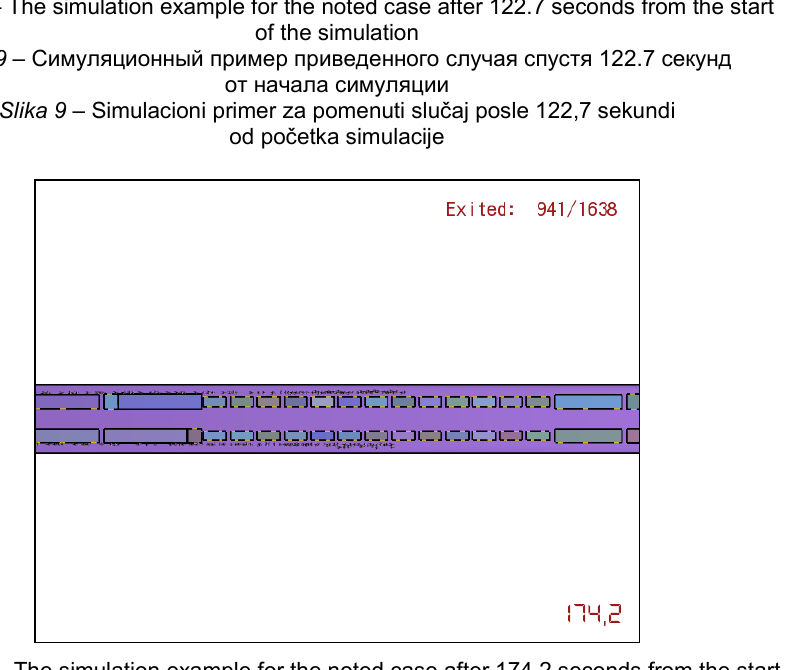
Figure 10 – The simulation example for the noted case after 174.2 seconds from the start of the